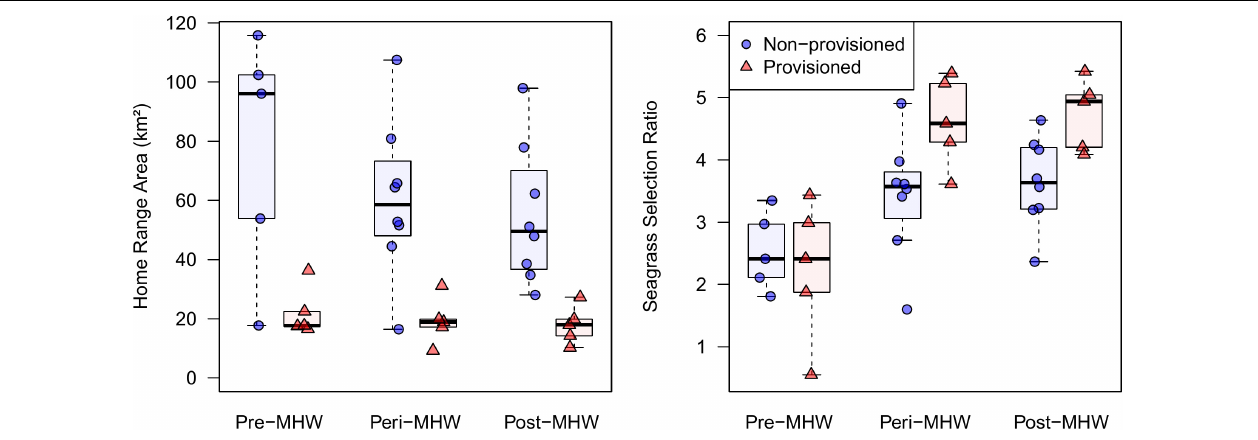
FIGURE 2 | Home range sizes and seagrass selection ratios for provisioned ( n = 6) and non-provisioned ( n = 11) animals in the pre (2005–2010), peri (2010–2015), and post (2015–2019) seagrass die-off periods. Home ranges and seagrass usage were estimated from averaging the results from 100 iterations of 35 randomly selected locations per animal. Home range area was derived from 95% contours of kernel utilization distributions, and seagrass selection ratios were determined using Manly’s type II design, adjusted for availability post-MHW. Provisioned animals had significantly smaller home ranges than non-provisioned ( β = –55.07, p = 0.001). All animals had higher seagrass selection ratios in the peri and post eras relative to pre-MHW ( β = 1.11, p < 0.024). TABLE 1 | Home range size and seagrass selection ratios for provisioned and non-provisioned females in the pre-MHW (2005–2010), peri-MHW (2010–2015), and post-MHW (2015–2019) time frames. Home range size Seagrass selection ratio